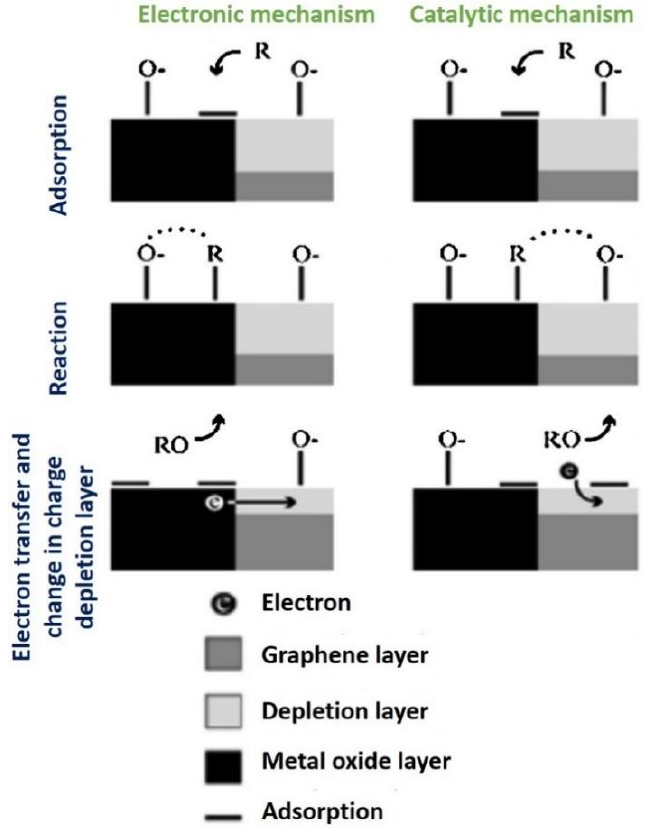
Figure 6. Schematic diagram of the general steps involved in the electronic and catalytic interactions between the graphene-based gas-sensing layers and the metal oxide.